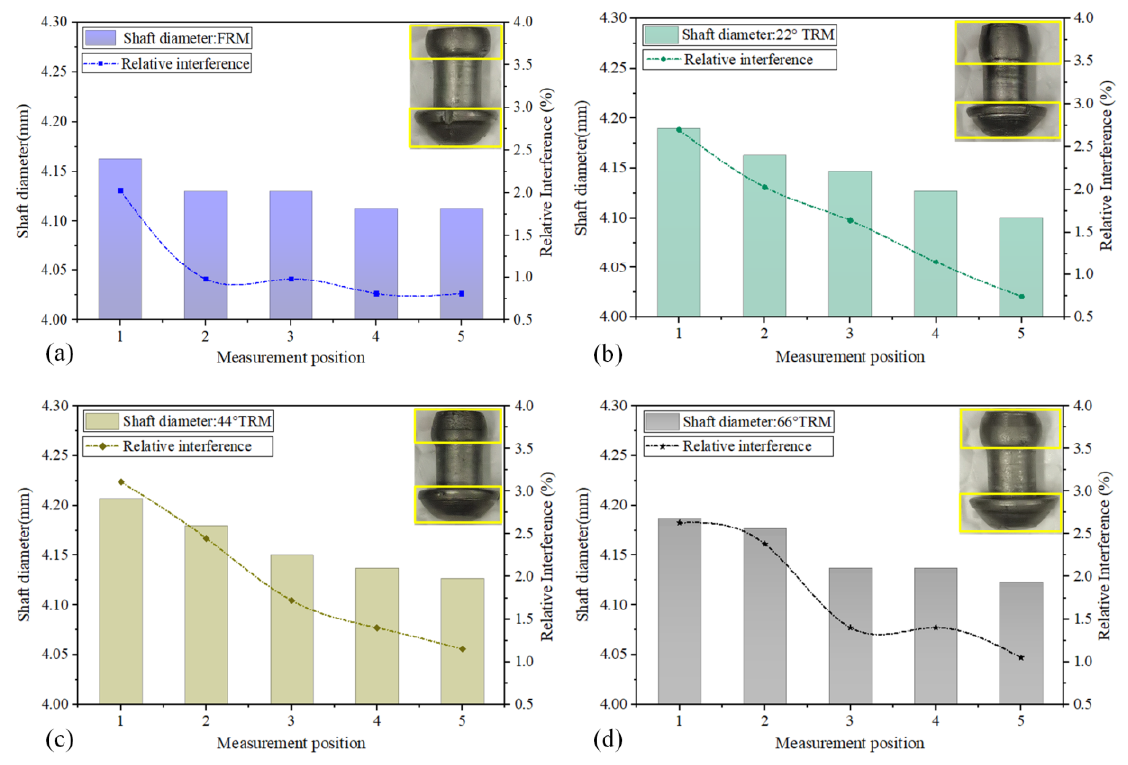
Figure 11. Diameter and interference-fit size results with different riveting molds: ( a ) FRM, ( b ) 22° TRM, ( c ) 44° TRM, ( d ) 66° TRM.